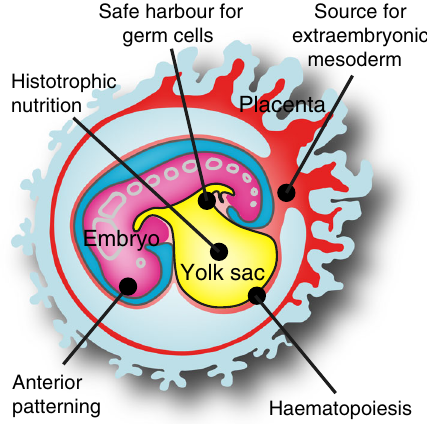
Fig. 6 Principal functions of the primate hypoblast and yolk sac. Graphical illustration summarising the roles of the hypoblast — yolk sac lineage during early primate